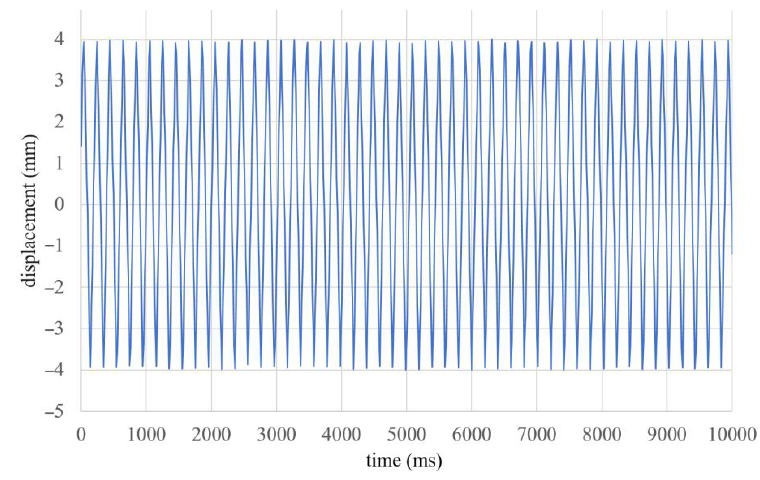
Figure 13. Continuous measurement of EM valve.